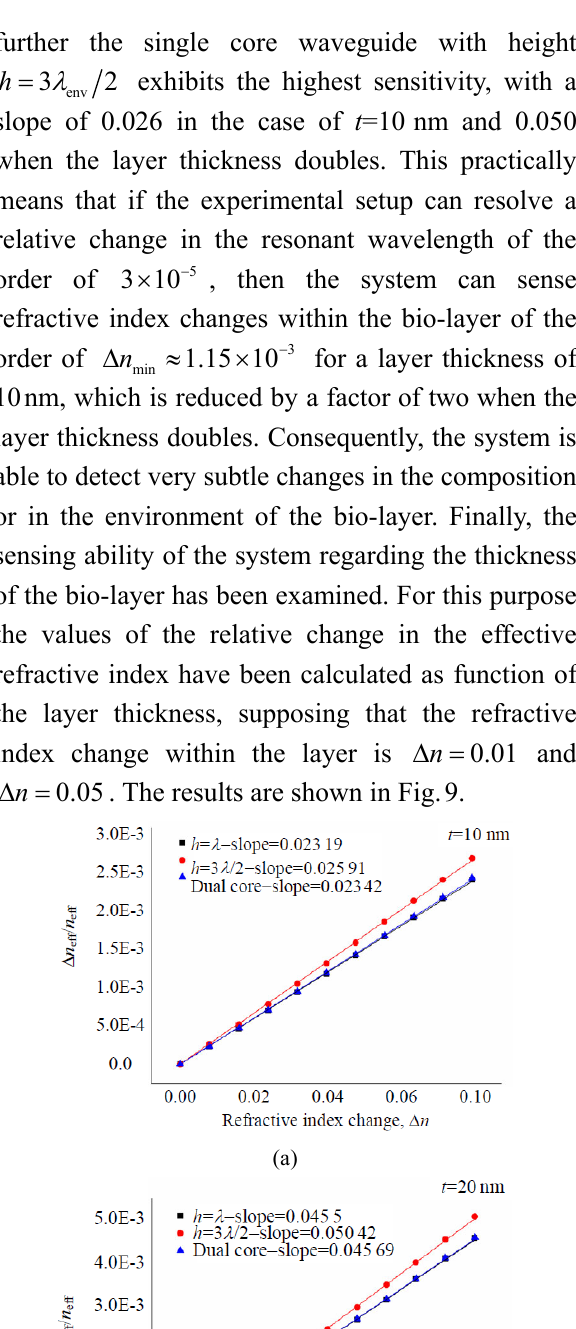
as function of the layer p